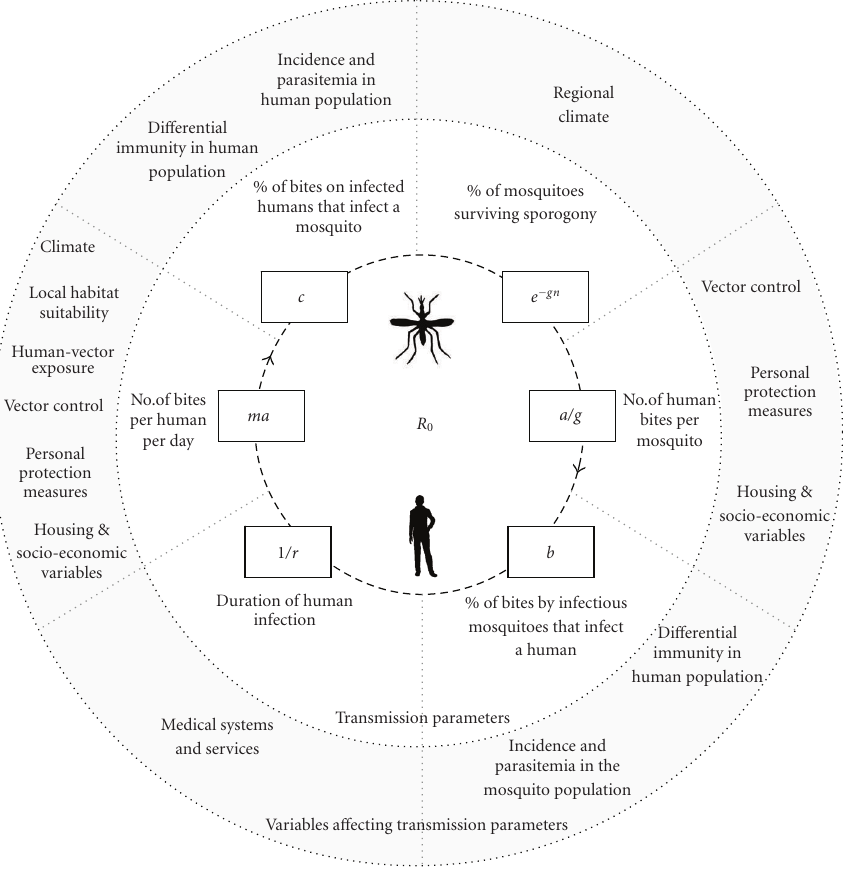
Figure 4: Malaria life cycle model. The inner model of malaria transmission parameters is based on a diagram and parameters from Smith et al. 2007 [97]. Parameter definitions: R 0 (basic reproductive number) = ma 2 bce − gn /rg, a (human feeding rate): the number of bites on a human, per mosquito, per day, b (transmission e ffi ciency): the probability that a human becomes infected from a bite by an infectious mosquito, c (transmission e ffi ciency): the probability that a mosquito becomes infected from a bite on an infected human, g (death rate of mosquitoes): expected lifespan of a mosquito in days: 1/g, m : ratio of mosquitoes to humans, n (incubation period): number of days required for the parasite to develop within the mosquito, 1/ r : duration of infection in